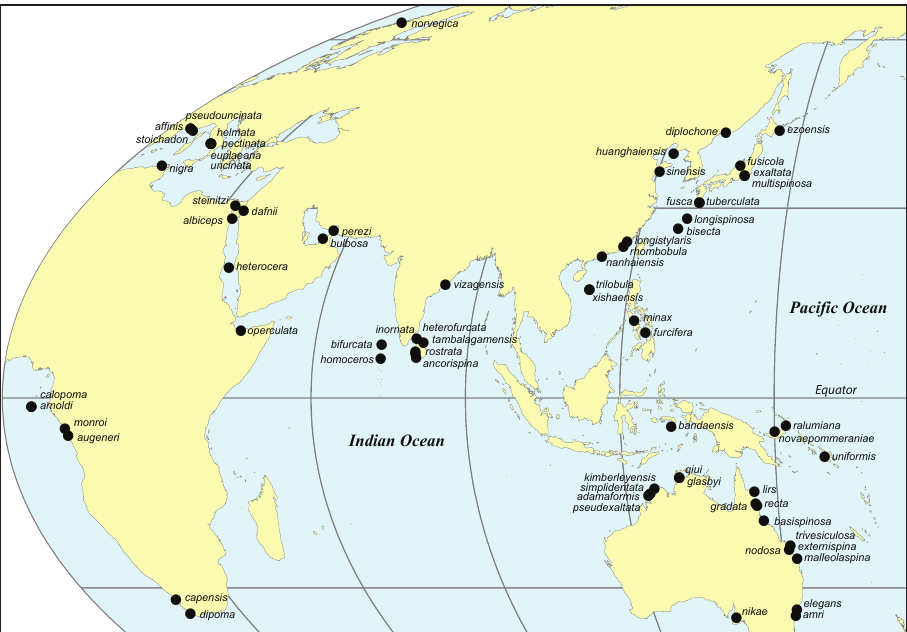
Figure 1. Hydroides species type localities of the Eastern Hemisphere (Indian Ocean and Western Pacific). Labels are current species-group names (except homonym H . rostrata renamed herein as H. gottfriedi nom.